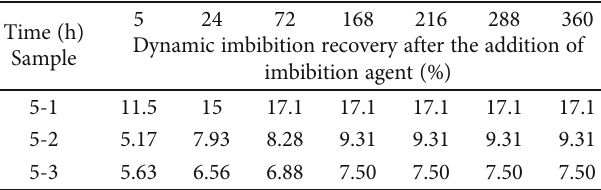
Table 4: Core static imbibition data with surfactant.